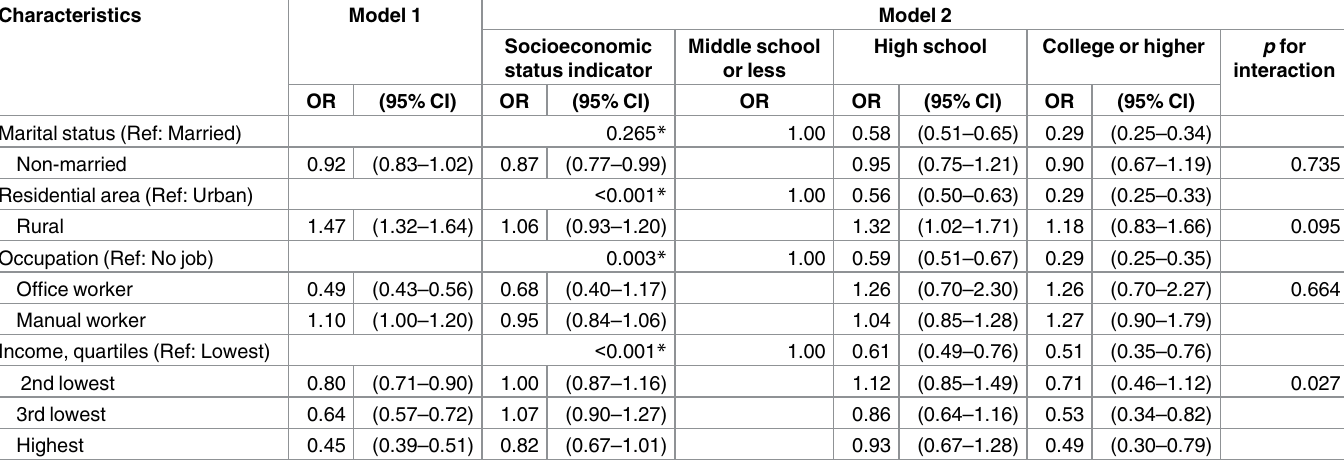
Table 5. Unadjusted results of the main and interaction effects of each socioeconomic status indicator and education on obesity in women.